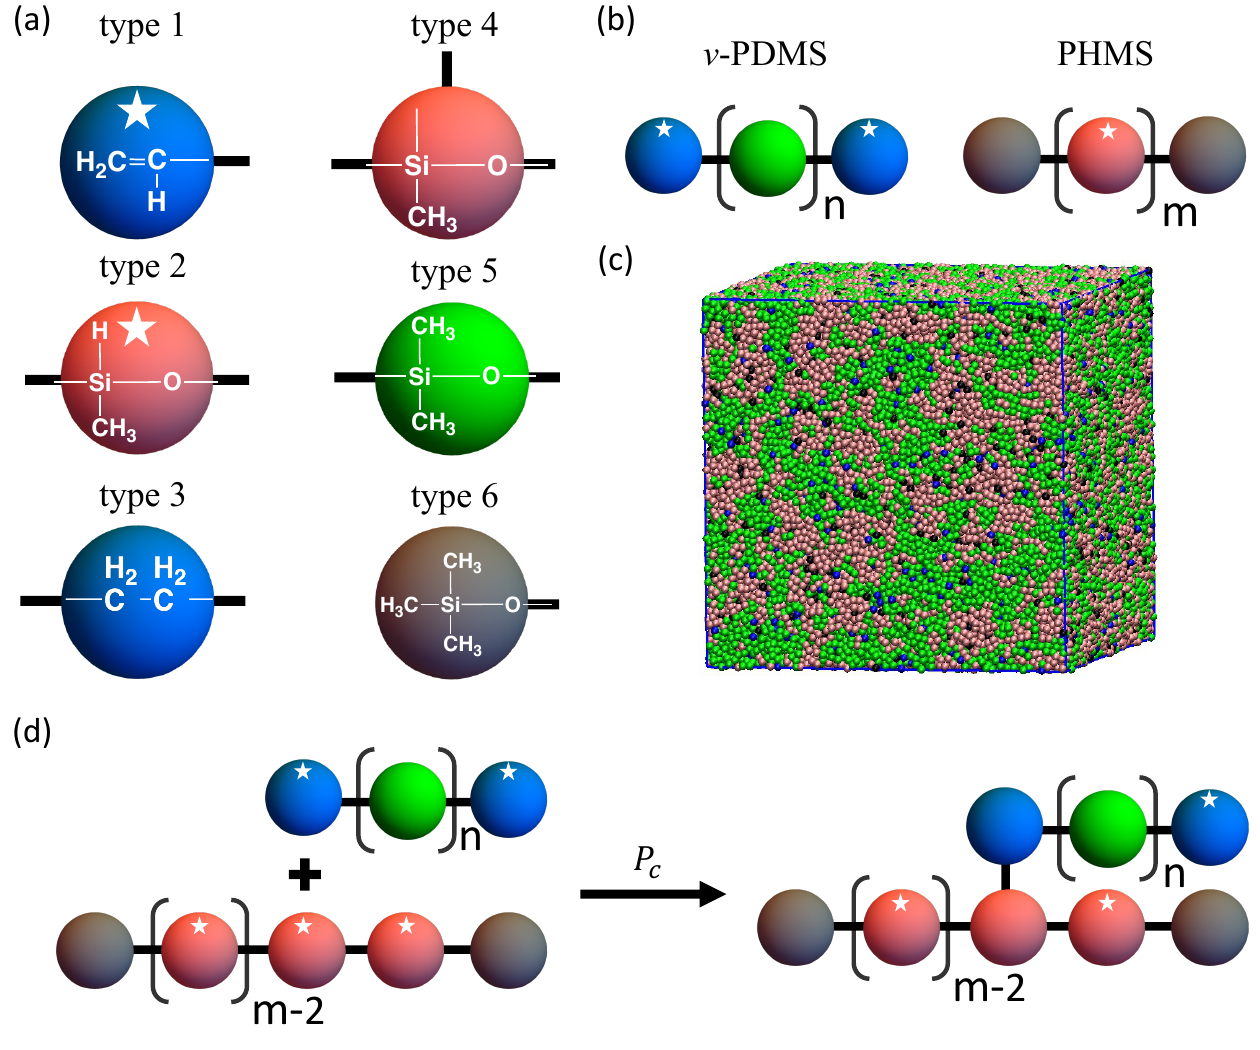
Figure 1. ( a ) Types of coarse-grained beads, “ (cid:70) ” indicates that the bead is reactive, ( b ) schematic representation of the v -PDMS and PHMS chains, ( c ) schematic of the hydrosilylation reaction, ( d ) ini- tial morphology snapshot (generated with a ii = 78 for all the beads; no reactions occur during the equilibration) for a sample with f v − PDMS = 0.5, N PHMS = 30, and N v − PDMS = 100. The interaction parameters between all the types of beads are provided in Table S4 of Supplementary